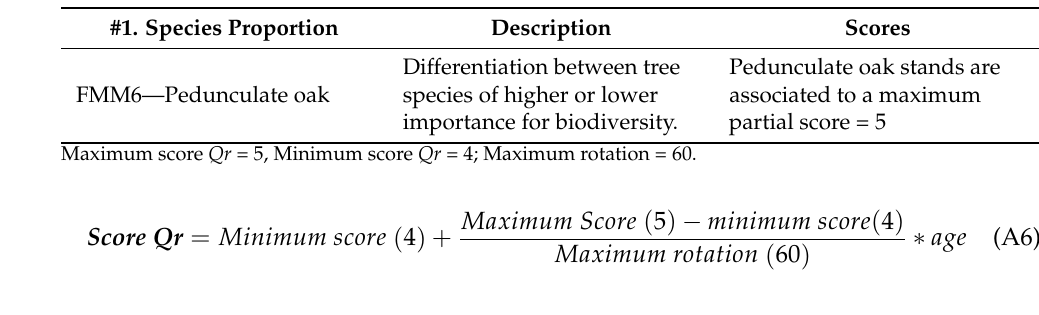
Table 6. Species proportion, description, minimum and maximum values used to define the FMM6 biodiversity score.